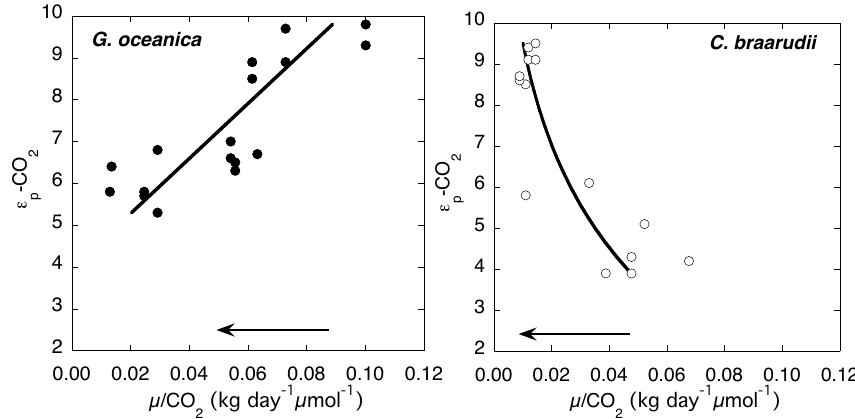
Fig. 7. The isotopic composition ( δ 13 C POC ) of organic matter calculated as ε p relative to CO 2 for G. oceanica (black circles) and C. braarudii (open circles) and plotted versus µ /CO 2 . The arrows indicate the direction of increasing carbon in the experiments to highlight the inverse nature of the isotopic fractionation response between the two